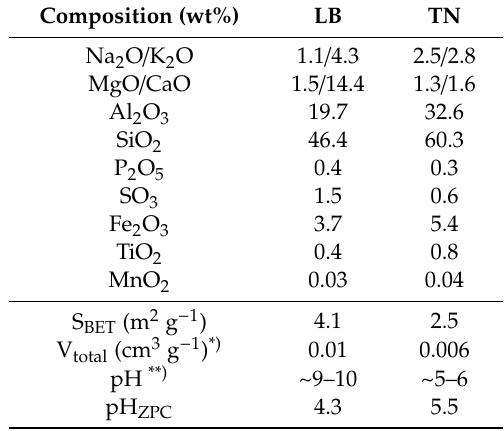
Table 1. Chemical composition, pH of the zero point of charge (pH ZPC ) and specific surface area (S BET ) of waste brick dust (WBD) from Libochovice (LB) and Tyn nad Vltavou